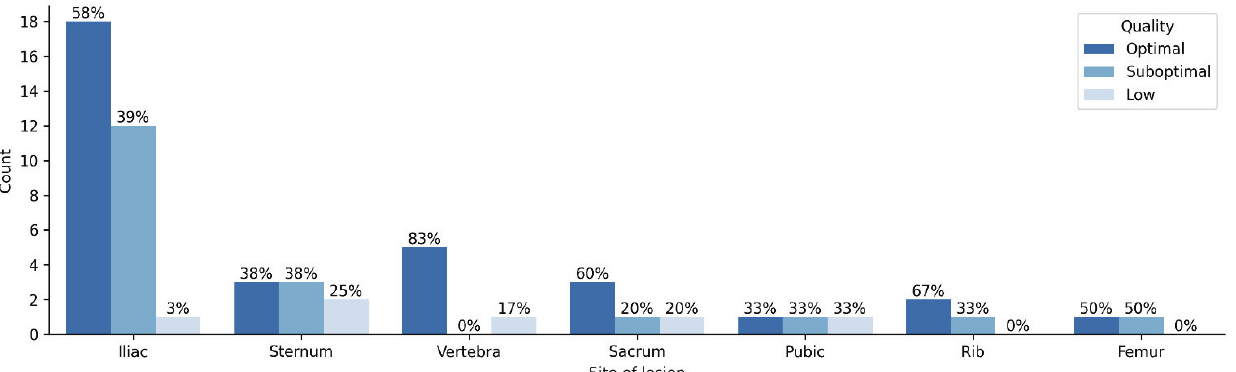
Figure 3. Sample quality and radiological characteristics of lesions.